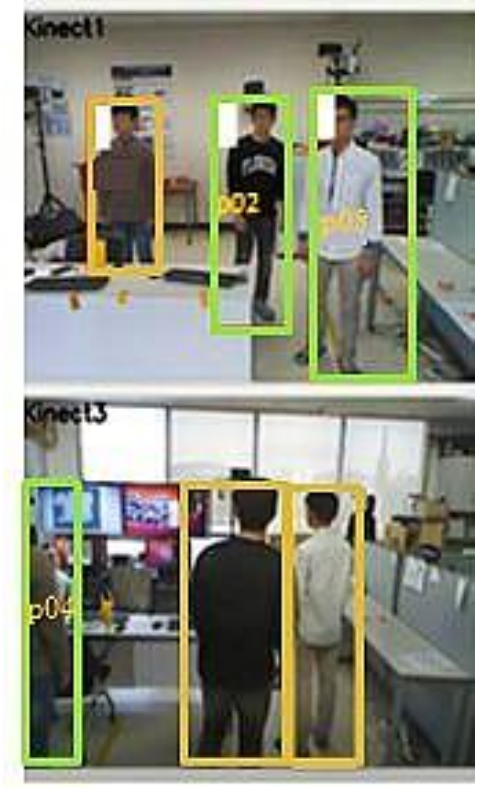
Fig. 6: WHERE fusion of orthogonal con(cid:28)guration (keeps correctly 3 detected humans (green ROI rectangular) form total 6 detected humans).